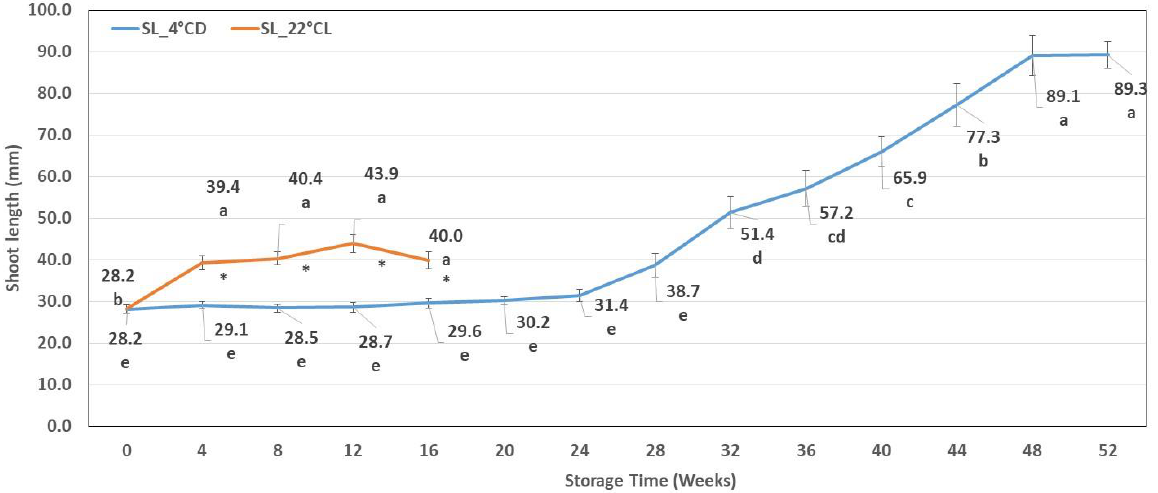
Figure 1. Shoot length (SL) during cold storage (SL_4 °CD) and during storage in the growth chamber (SL_22 °CL). Line graphs present mean values ± SE of SL. Lower case indicates the significant differences between the SL measured after different storage times. * indicates the significant differences between the SL measured after different storage conditions.